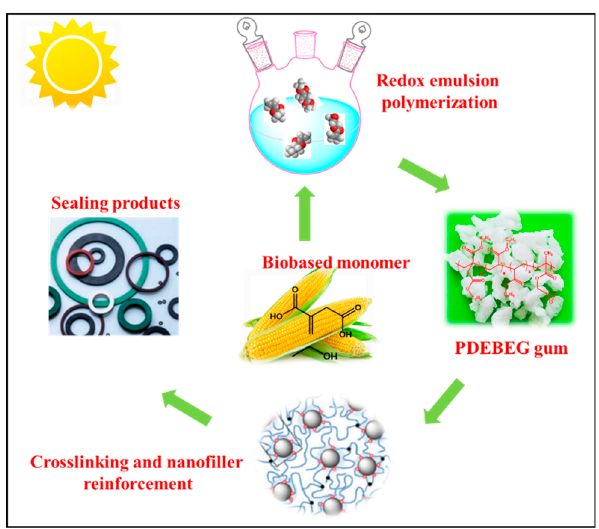
Figure 1. Design and preparation route of the novel elastomer with bio-based diethyl itaconate.